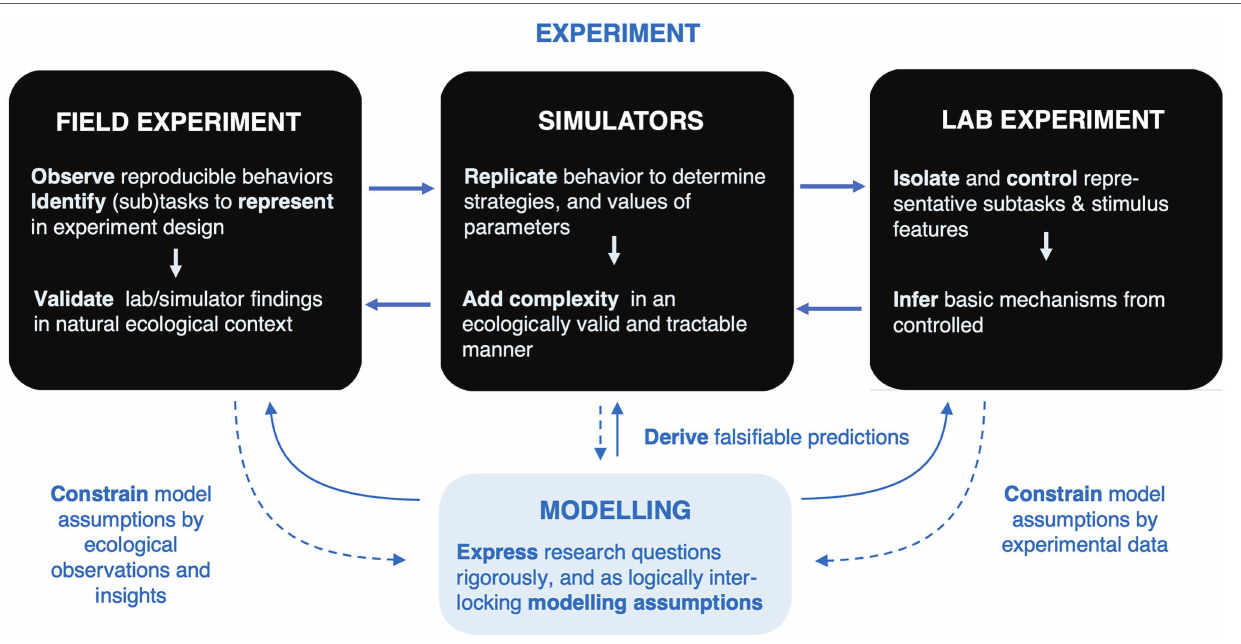
FIGURE 1 | An ecological approach to natural gaze behavior. There is more than one way of making sure experiments and models capture real-world phenomena (rather than accounting for laboratory behavior only). The only way, or the best way, “into the wild” is not necessarily to take laboratory experiments and “make them more ecological,” adding more “naturalistic” features (starting from the bottom of the right-most black box). Or one may begin with real-world observation , that is, measurement and analysis of natural behavior not just anecdotal observation (starting in the top of the left-most box), identify candidate behaviors to experiment on and to model. Other routes are possible as